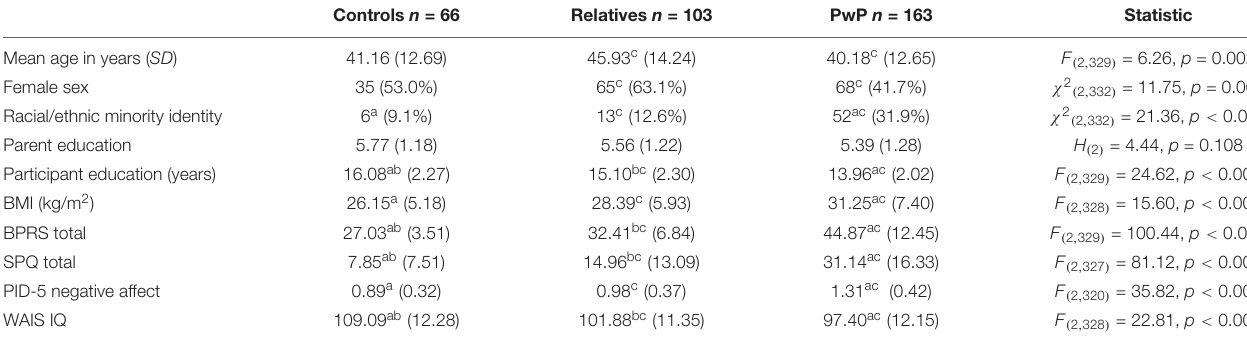
TABLE 1 | Demographic and clinical